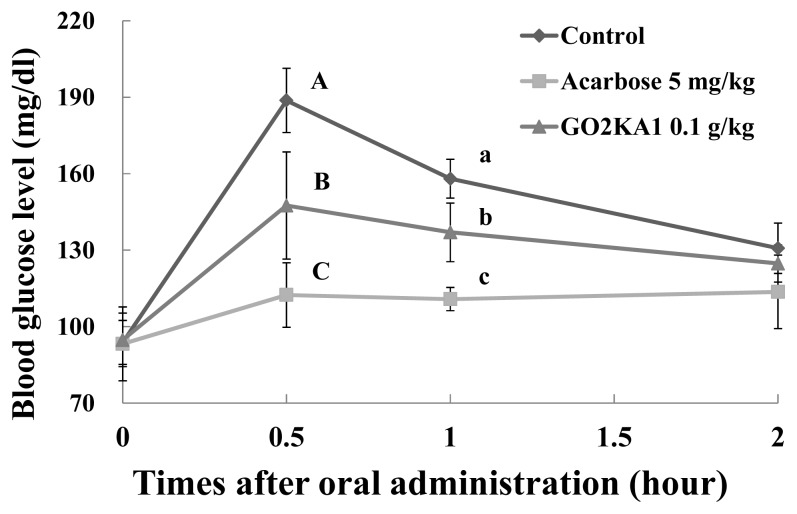
Effect of GO2KA1 on sucrose loading test. After fasting for 24 h, six-week-old, male SD rats were orally administered with sucrose solution (2.0 g/kg) with or without samples (GO2KA1; MW < 1000 Da, positive control; Acarbose). Each point represents mean ± S.D. (n = 5). A−C Different corresponding letters indicate significant differences (p < 0.05) at 0.5 h by Duncan’s test. a−c Different corresponding letters indicate significant differences (p < 0.05) at 1.0 h by Duncan’s test.